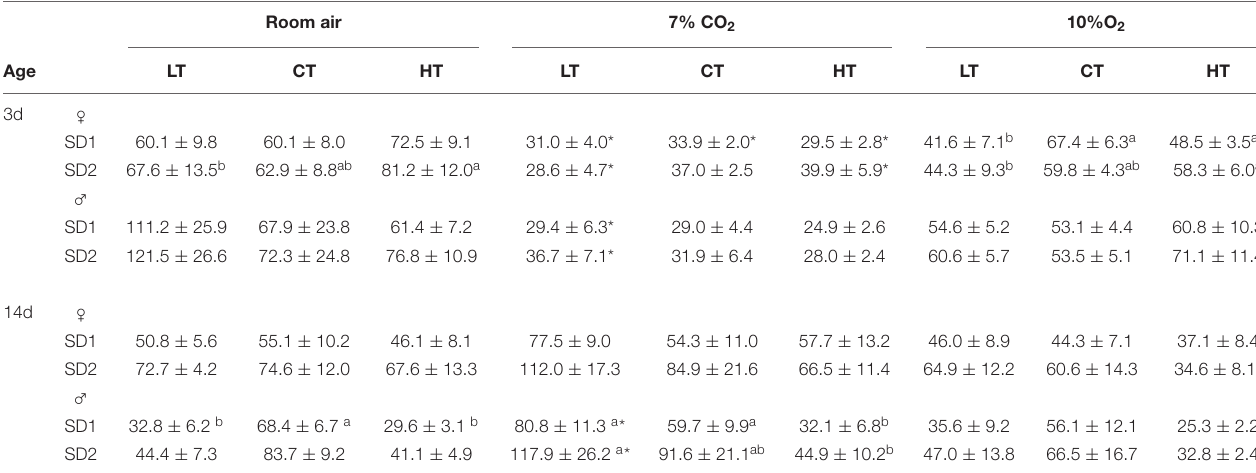
TABLE 3 | The variability of breath duration (mean ± SEM) during room air (21% O 2 ), hypercapnia (7% CO 2 ), and hypoxia (10% O 2 ) exposure of 3- and 14-days-old male and female chicks incubated under control (CT; 37.5 ◦ C) or at higher (HT; 39 ◦ C) or lower (LT; 36 ◦ C) during 6 h/day, from day 0 to 5 of incubation. Standard deviation (SD1 and SD2).